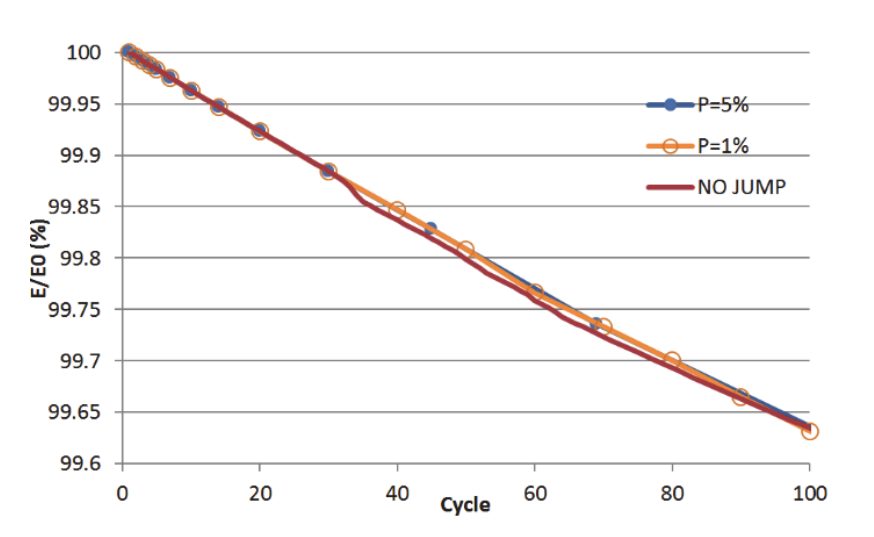
Figure 1: Effect of the N-Jump algorithm on stiffness